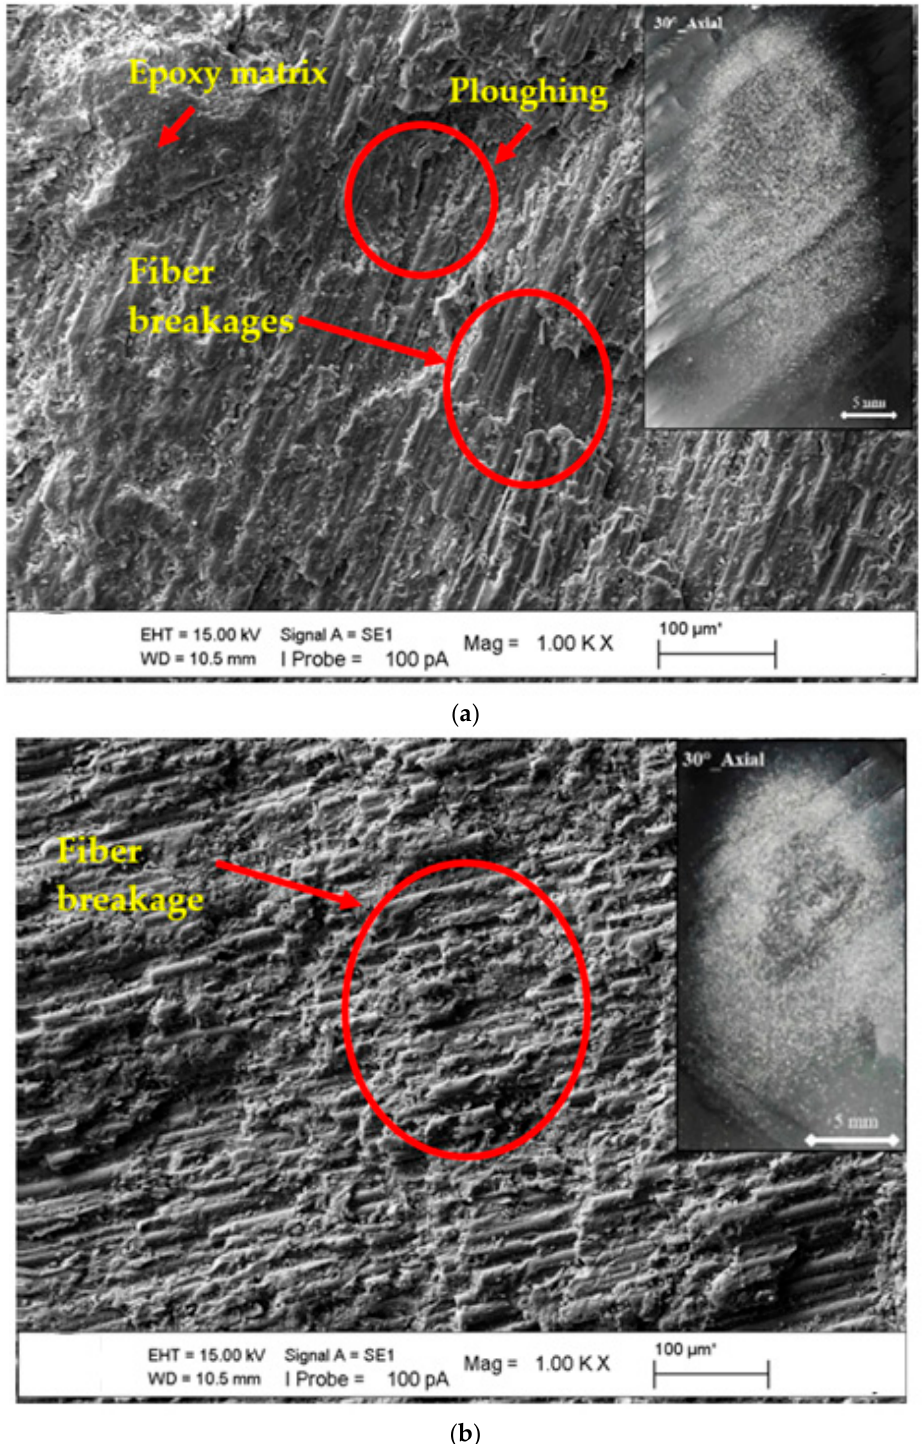
Figure 11. SEM images of matrix damages and fiber breakage on the surface at the 30° impingement angle with axial orientation: ( a ) lamina region and ( b ) zigzag region.